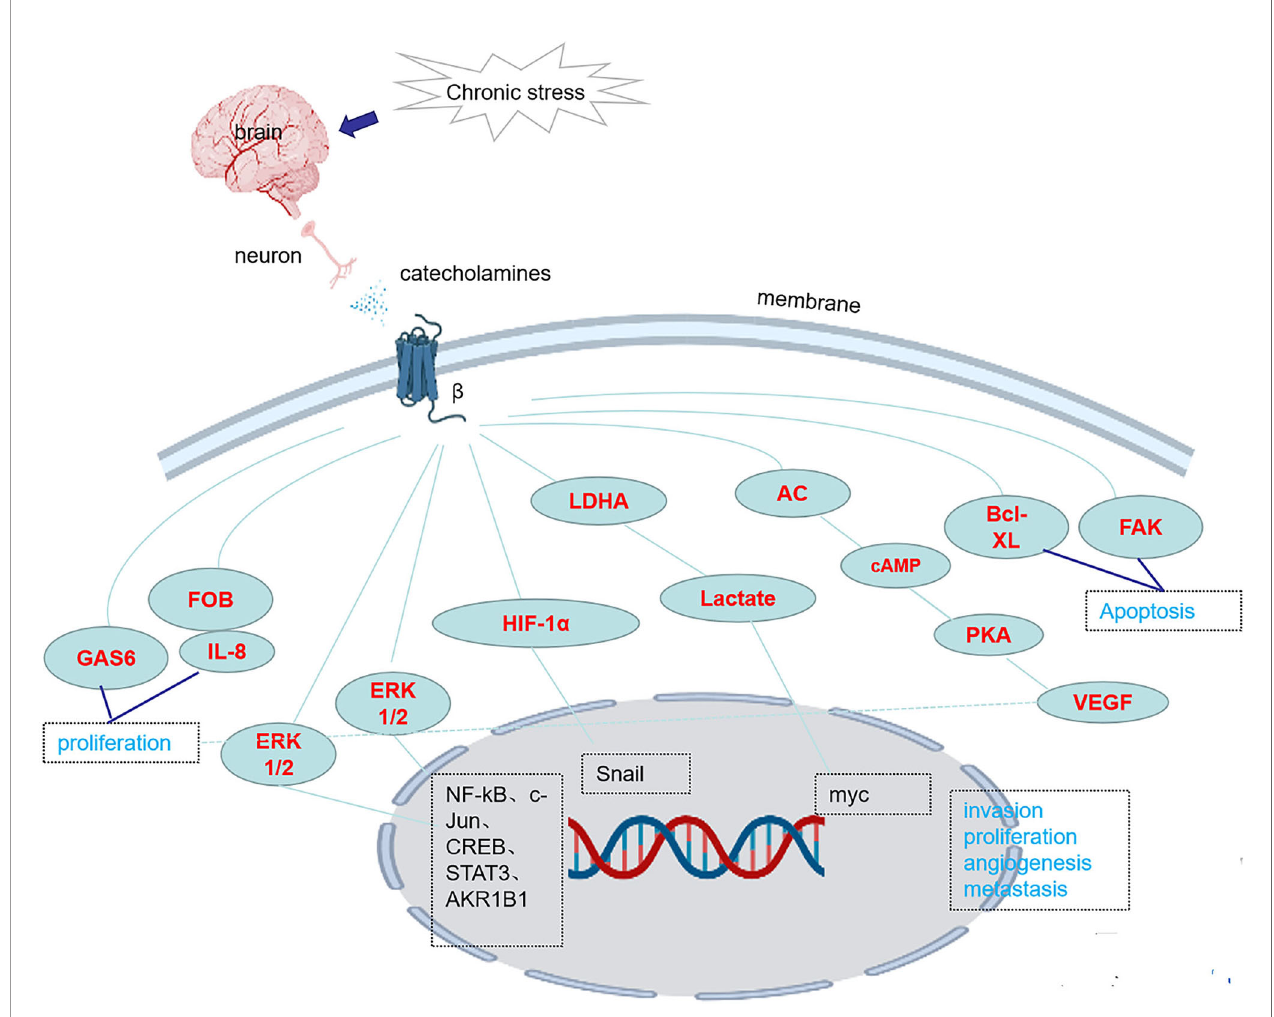
FIGURE 1 | Chronic stress activates the expression of genes/proteins in related pathways through b